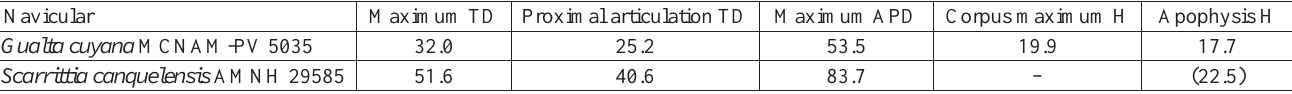
Table 5. Measurements (in mm) of the navicular of Gualta cuyana from Quebrada Fiera, Mendoza, compared with that of Scarrittia canquel- ensis from Chubut Province. Photographs of Scarrittia taken by Barbara Vera and Andrea Elissamburu. Values in parentheses are approximate. APD, anteroposterior diameter; H, height; TD, transversal diameter; – measurement not available.